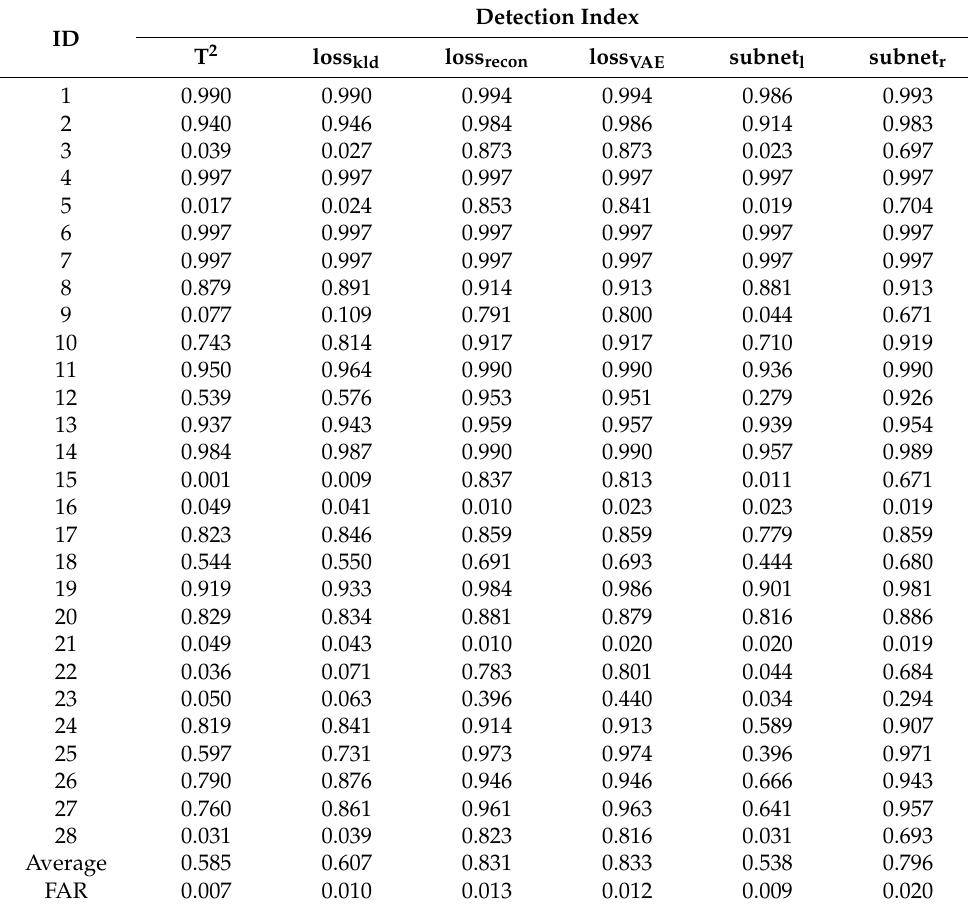
Table 3. Fault detection by VAE.